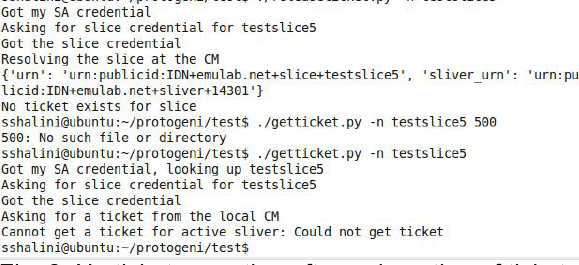
Fig. 2: No ticket operation after redemption of ticket as sliver act as active